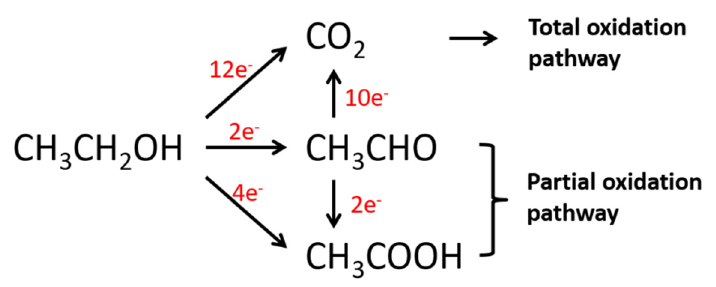
Figure 1. Schematic diagram of the parallel pathways during ethanol oxidation reaction (EOR) in acid media [11].